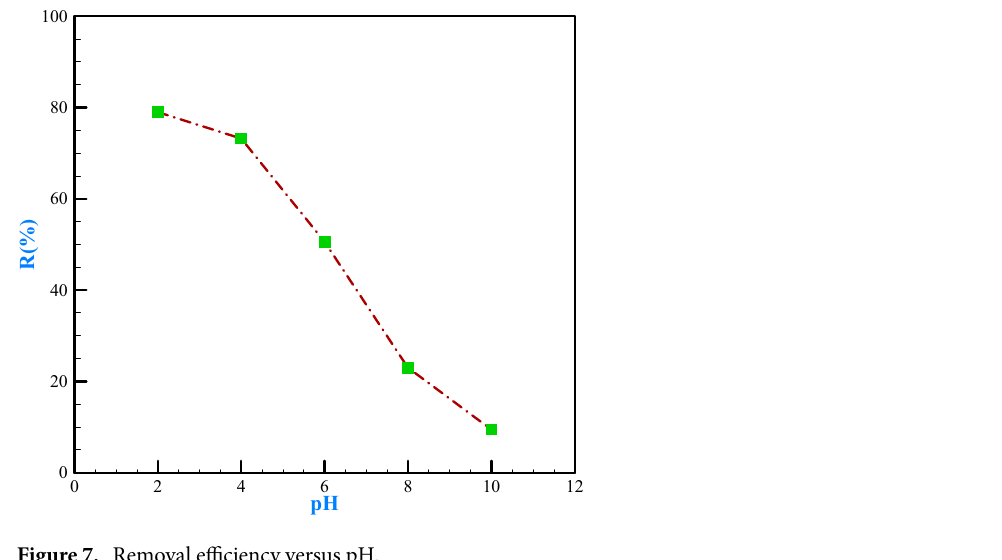
Figure 7. Removal efficiency versus